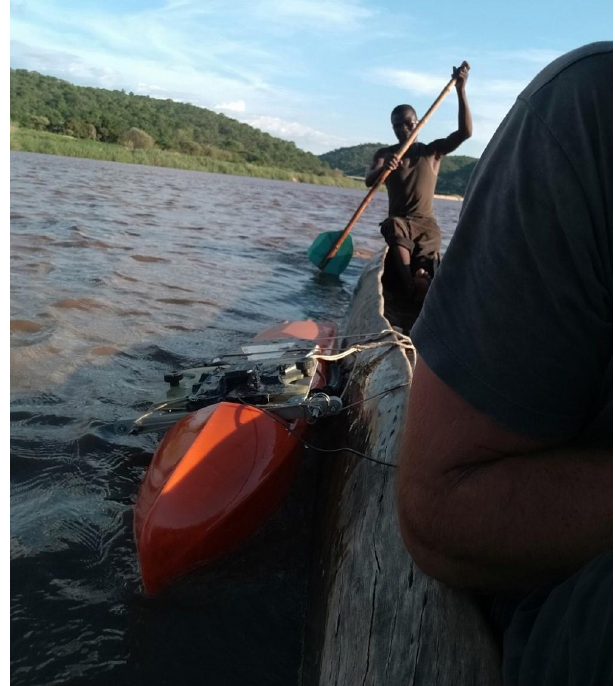
Figure A2. ADCP with a low-cost RTK GNSS attached to a